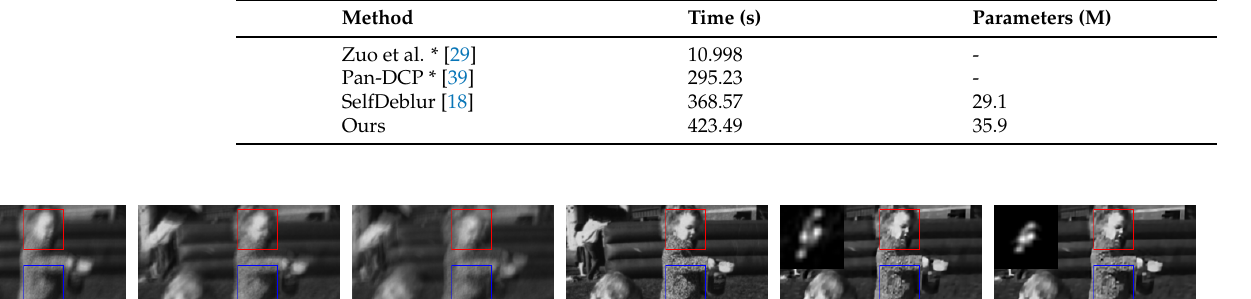
(i.e., ours {1,2} indicates our {}